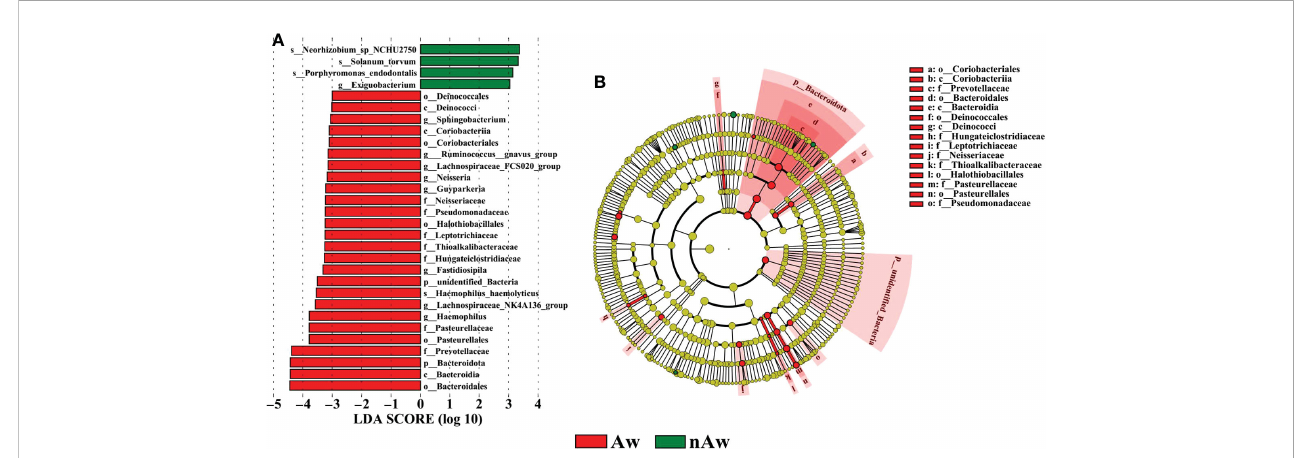
FIGURE 6 Linear discriminant analysis (LDA). (A) Histogram of the LDA scores (>3) computed for bacterial taxa differentially abundant between Aw and nAw. The size of each node represents the LDA score. (B) Bacterial taxa that were differentially abundant in the group visualized using a cladogram. The size of each node represents their relative abundance. Signi fi cantly discriminant taxon nodes are colored and branch areas are shaded according to the highest- ranked variety for that taxon. Aw, atopic wheezing group; nAw, non-atopic wheezing